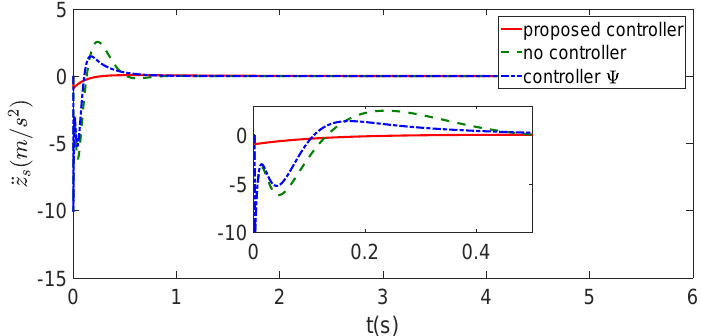
Figure 4. Vehicle body vertical acceleration.